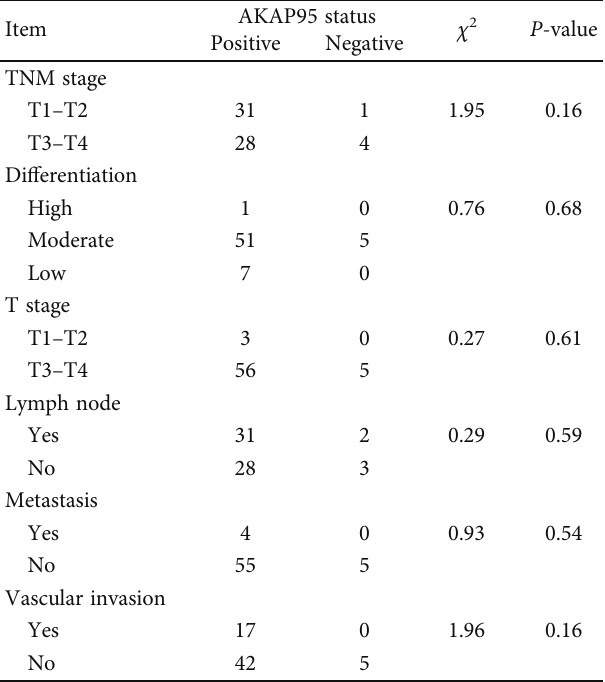
Table 2: AKAP95 protein expression associations with clinical – pathological parameters.